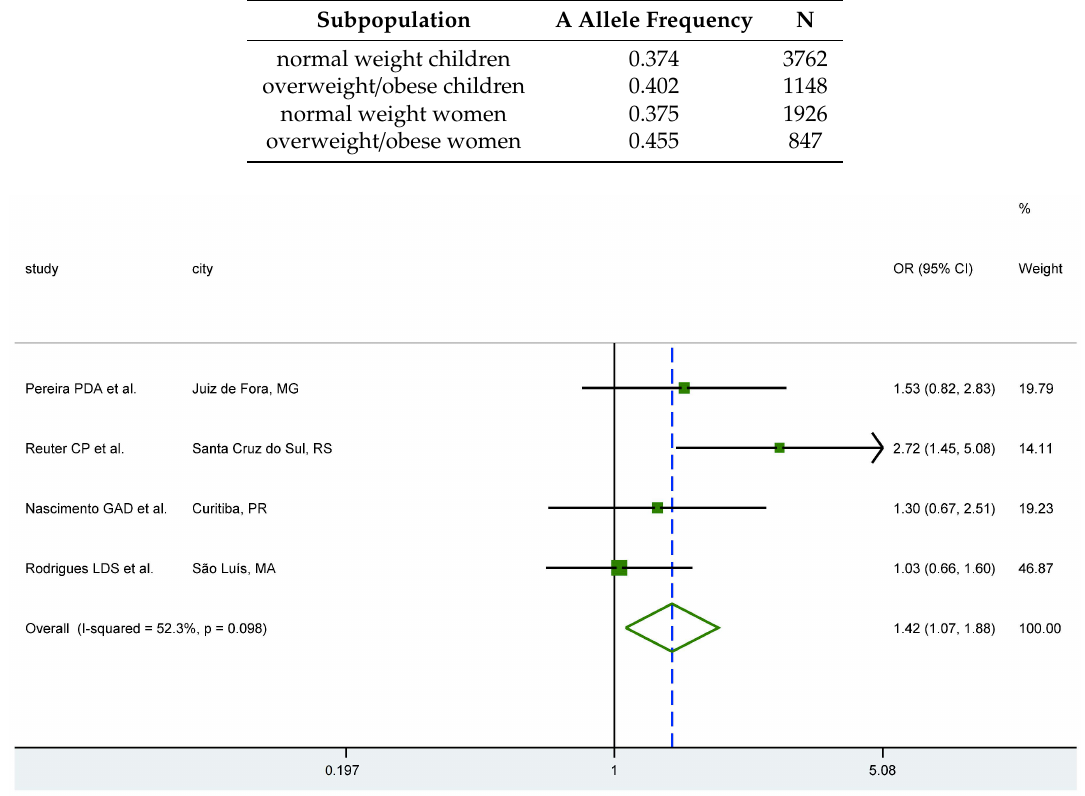
Figure 1. E ff ect of SNP rs9939609 ( FTO ) on being overweight or obese amongst Brazilian children and adolescents with the AA genotype vs those with the TT genotype